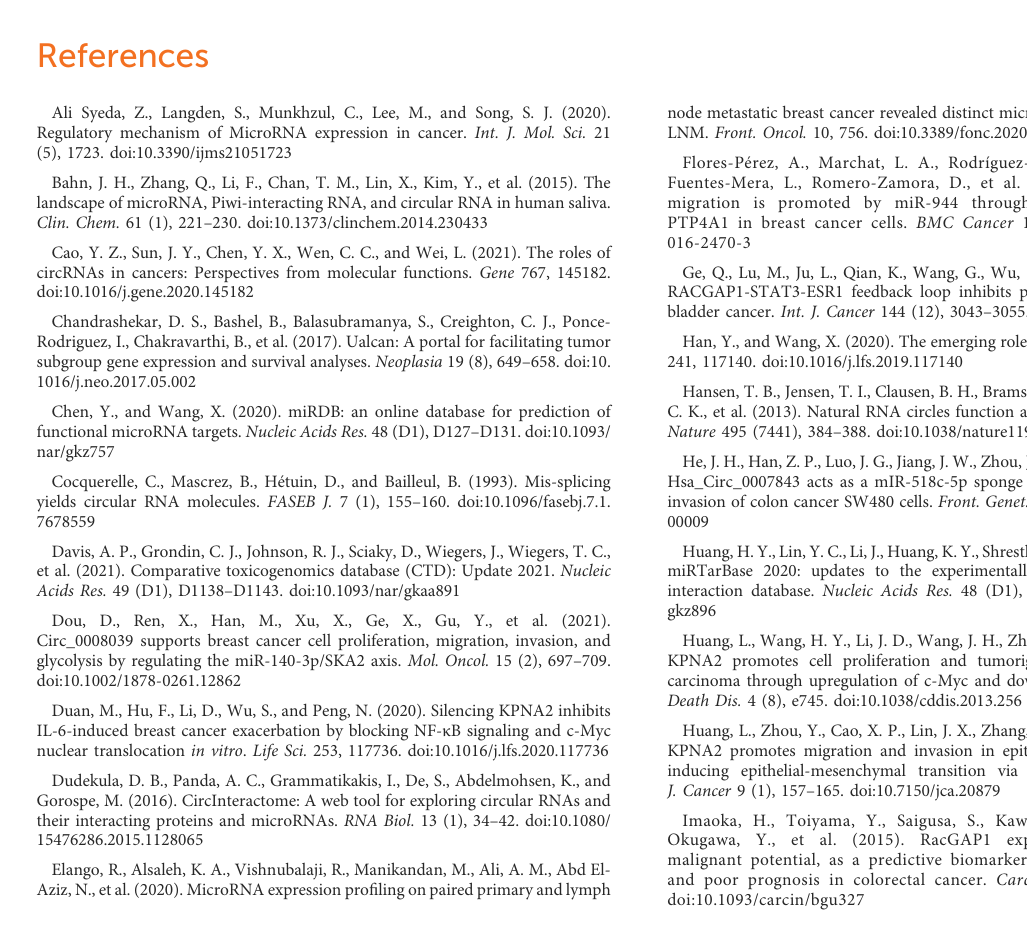
SUPPLEMENTARY FIGURE S1 The mRNA levels of hub genes in breast cancer and adjacent normal tissues. SUPPLEMENTARY FIGURE S2 ThemRNAlevelsofhubgenesinnormaltissuesandbreastcancertissues at different stages. SUPPLEMENTARY FIGURE S3 ThemRNAlevelsofhubgenesinnormaltissuesandbreastcancertissues of different